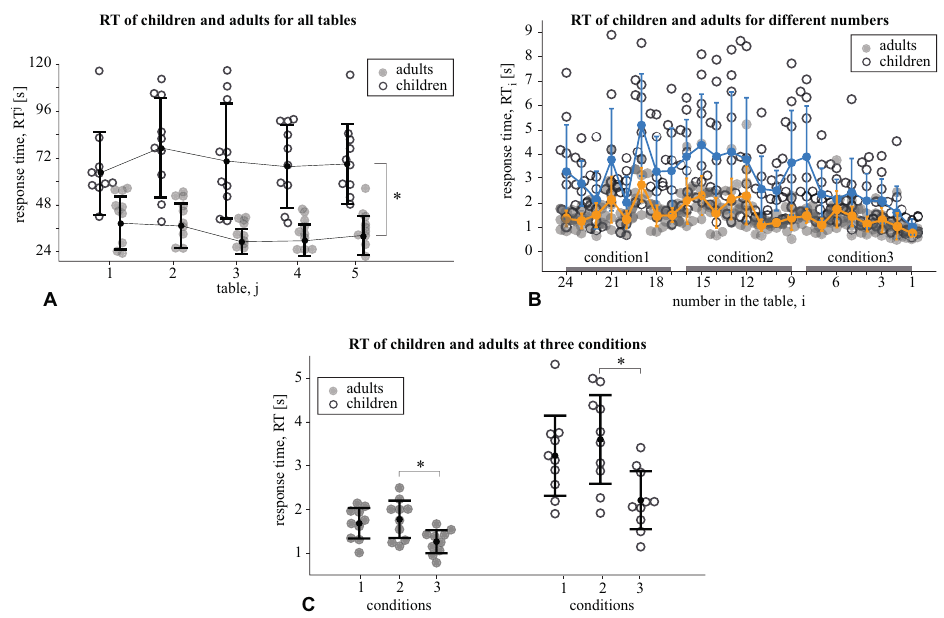
Figure 2. ( A ) The response times RT j of the j -th table accomplishment for the children and adults. Data are shown as the mean ± SD and the individual values ( ∗ p < 0.05 via a mixed-design ANOVA with the GreenHouse–Geisser correction). ( B ) the response time, RT i taken to find the i -th number in the Schulte table. Data are shown as mean ± SE for children and adults. Accomplishment time is divided into three intervals marked as condition1 , condition2 and condition3 . Each condition includes searching for eight numbers. ( C ) The mean RT in three conditions for the children and adults ( ∗ p < 0.05 via a mixed-design